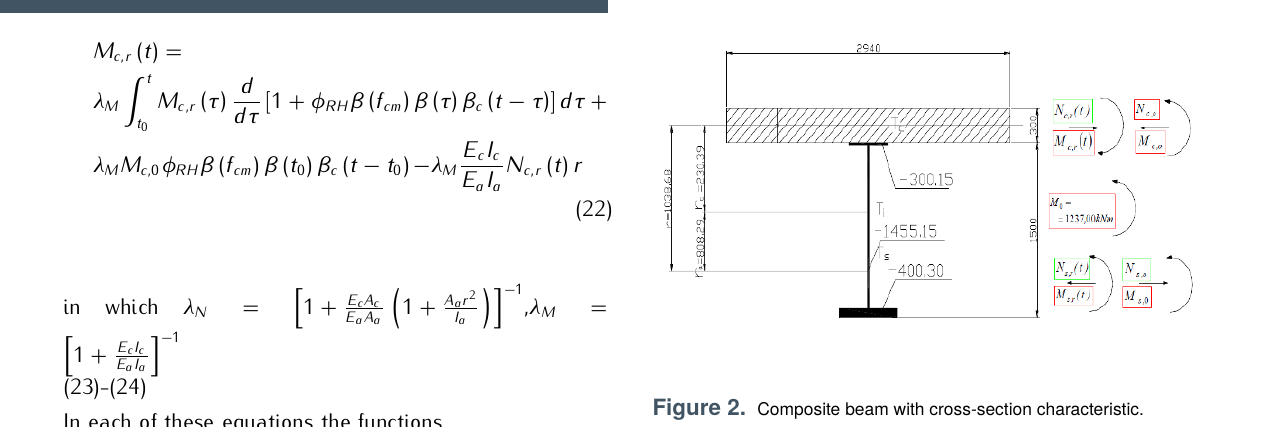
Figure 2. Composite beam with cross-section